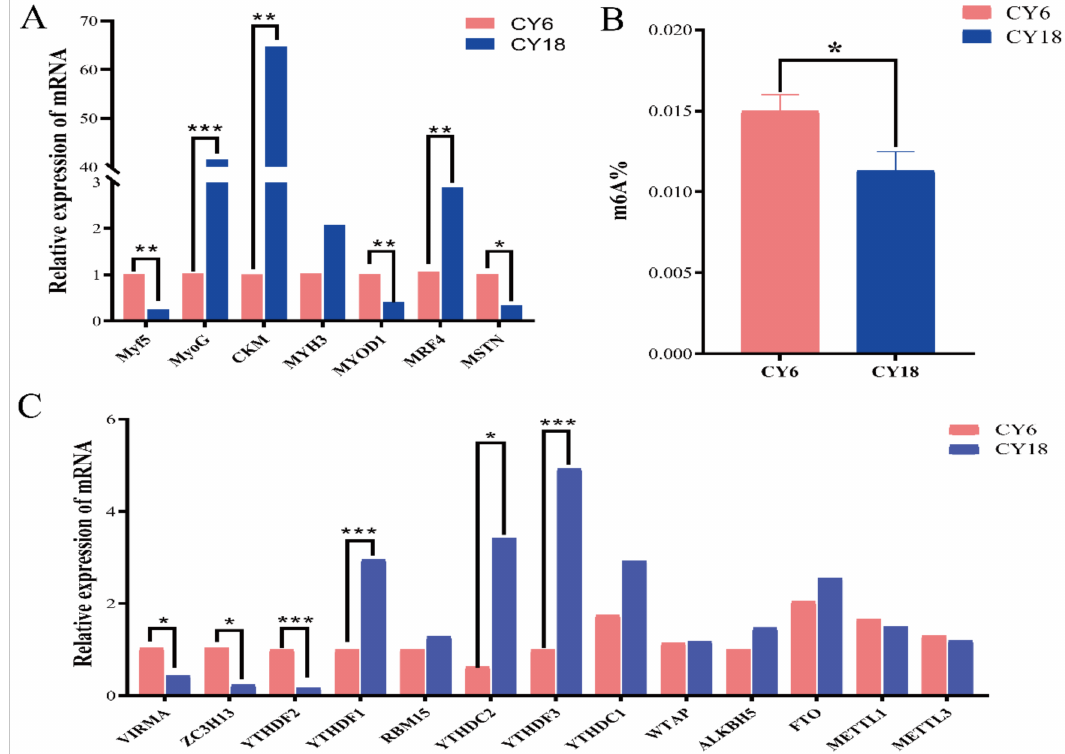
Figure 1. The analysis of muscle-related marker genes and the detection of m 6 A level at different development stages of cattle-yaks: ( A ) relative expression of muscle-related marker genes between six-month-old cattle-yaks (CY6) and eighteen-month-old cattle-yaks (CY18); ( B ) overall m 6 A content between CY6 and CY18; ( C ) the identification of expression levels of methylation-related genes. “***” p < 0.001, “**” p < 0.01, “*” p <